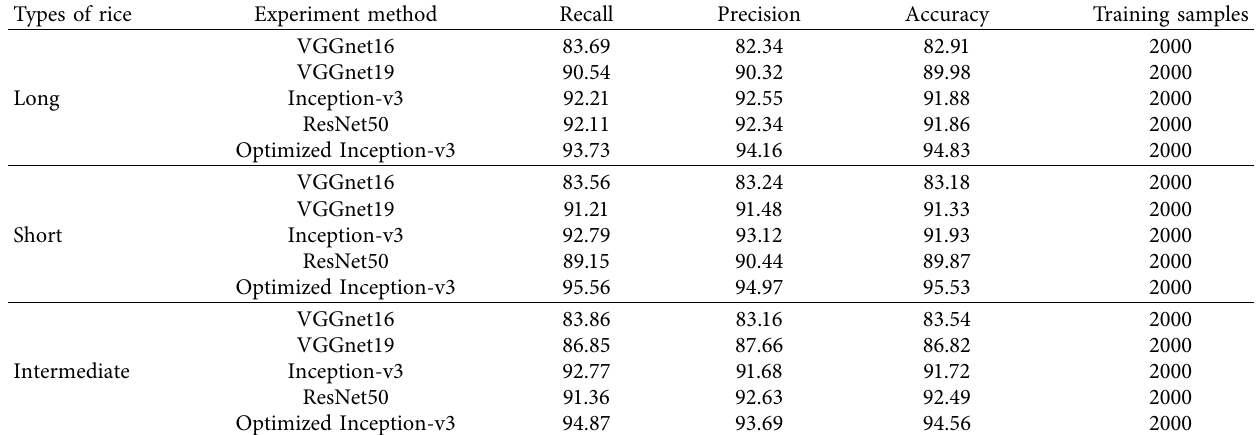
Table 7: Contrast test